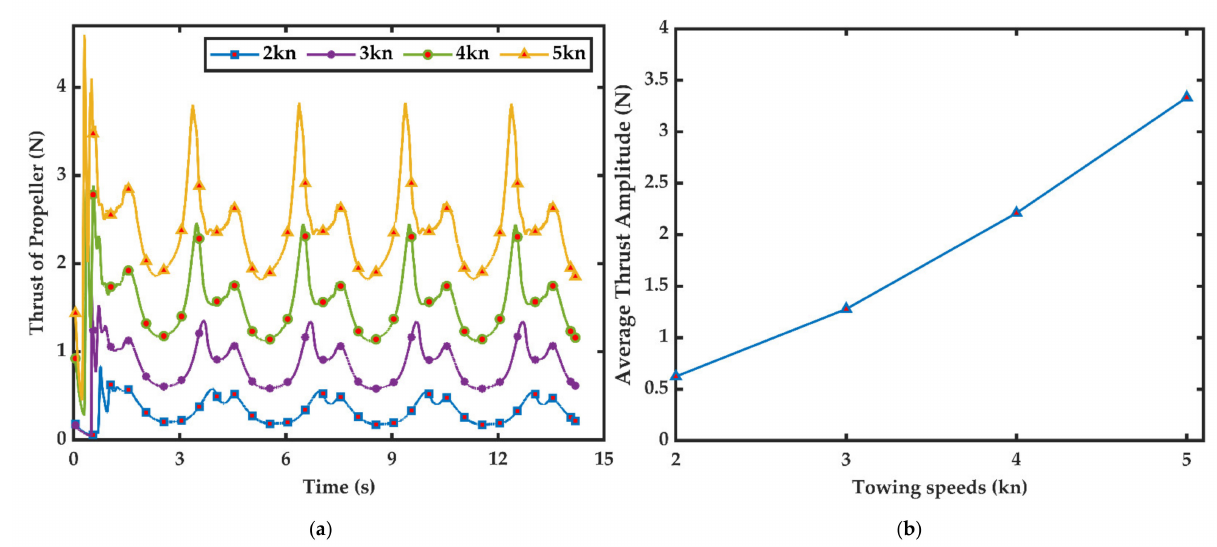
Figure 13. Time history of the thrust of the ducted propeller at different towing speeds: ( a ) thrust of the ducted propeller; ( b ) average thrust